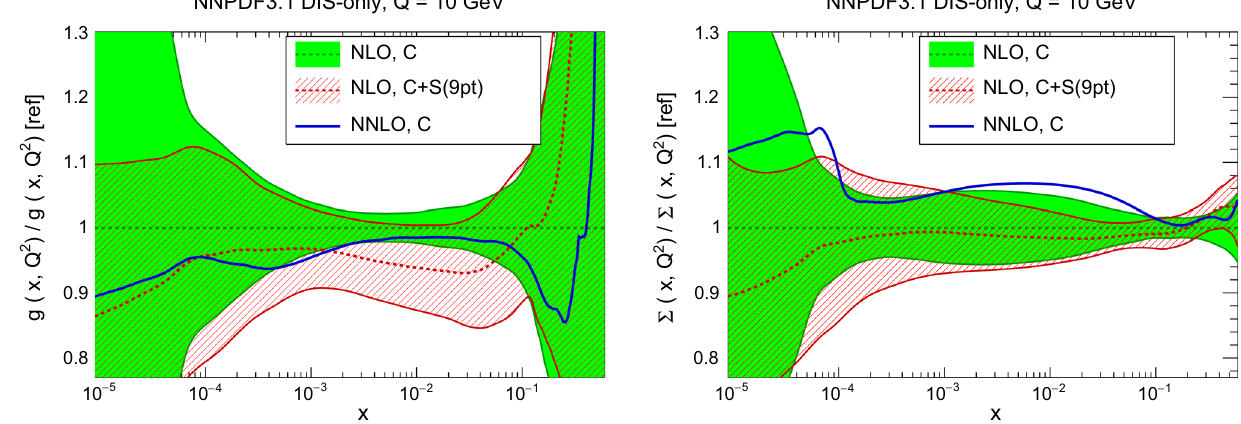
Fig. 15 Comparison of DIS-only PDFs determined with and without MHOUs in the covariance matrix. The gluon (left) and quark singlet (right) are shown at Q = 10 GeV. The theory covariance matrix S has been constructed using the 9-point prescription. The central value of the NNLO determined without MHOU is also shown. All results are shown